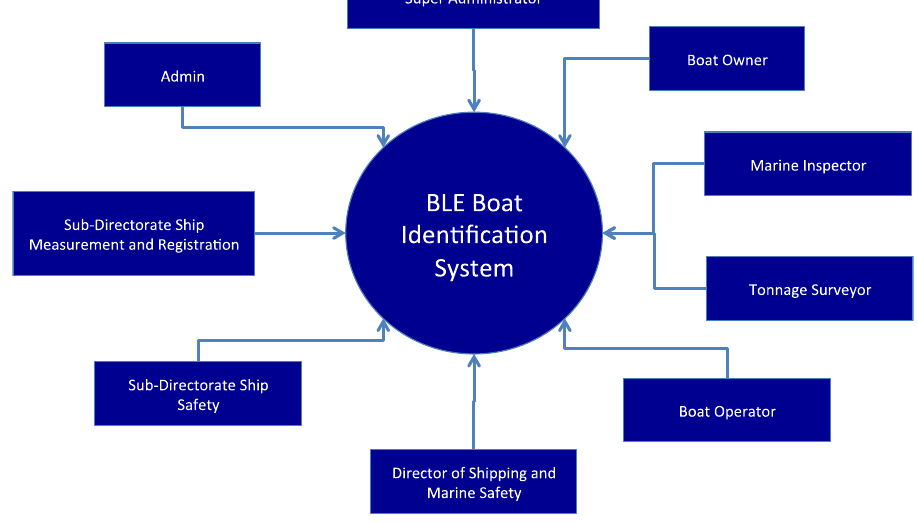
Fig. 8 BLE-based boat detec- tion system stakeholders